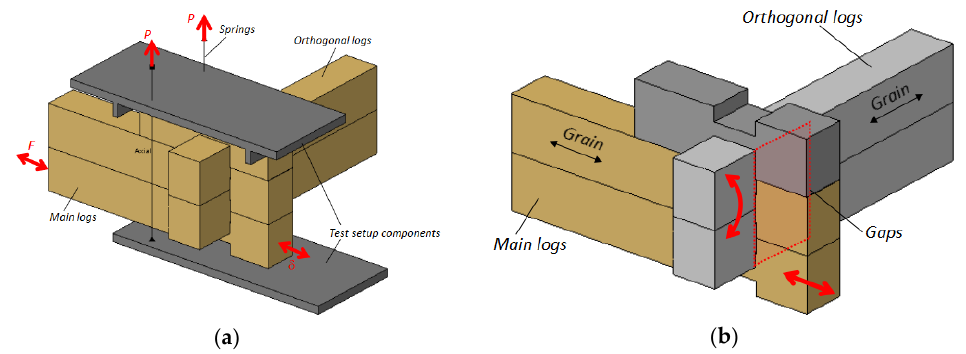
Figure 3. FE modelling of a Standard joint specimen (ABAQUS): ( a ) assembly view and ( b ) mechanical model.